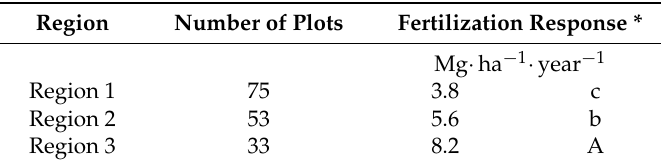
Figure 4. Distribution of fertilization response (FR) in 161 experimental plots. Table 5. Response to fertilization in the three